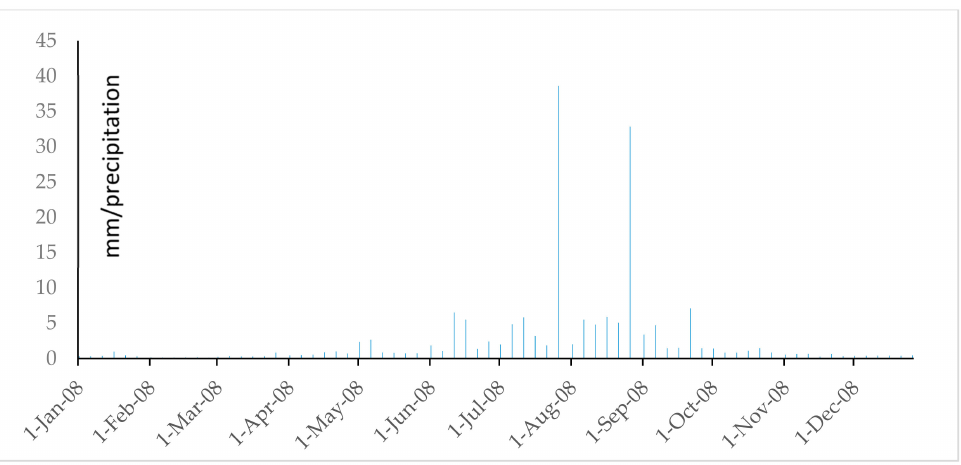
Figure A36. Precipitation of Denko County in